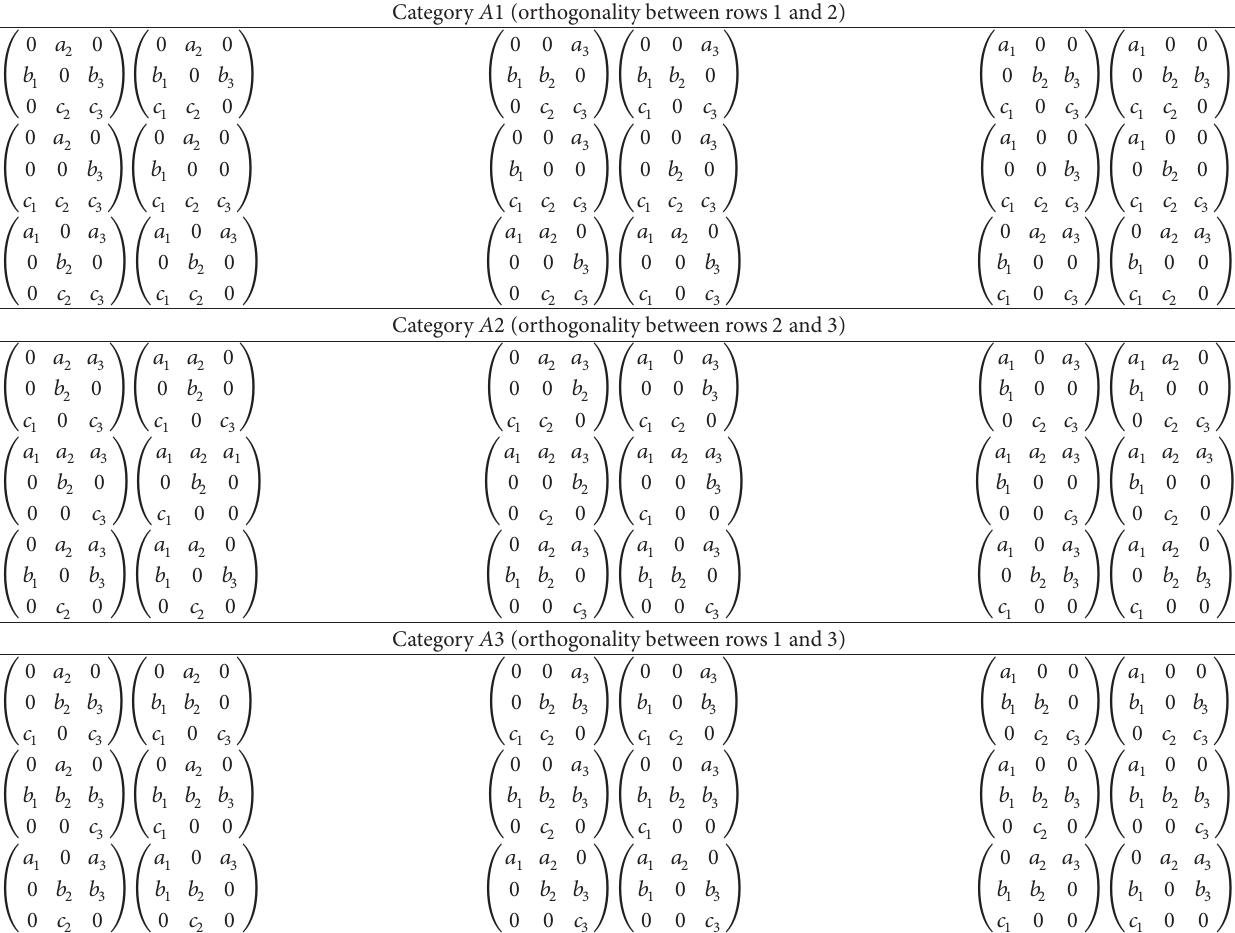
Table 1: Four zero Yukawa textures of 𝑀 𝐷 in Category 𝐴 with subcategories 𝐴1 , 𝐴2 , and 𝐴3 . Category 𝐴1 (orthogonality between rows 1 and 2 )